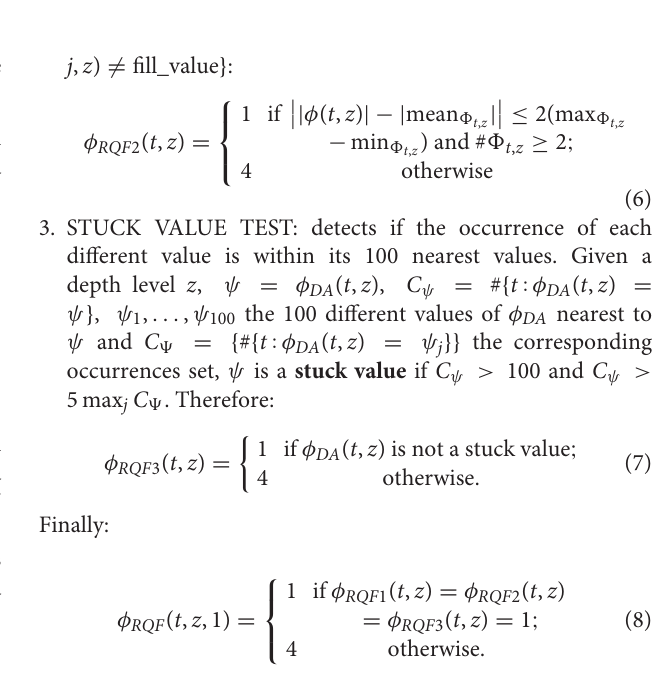
FIGURE 5 | Examples of erroneous data detection for sea water temperature by gross check: (A) OBSEA station; (B) Ponza